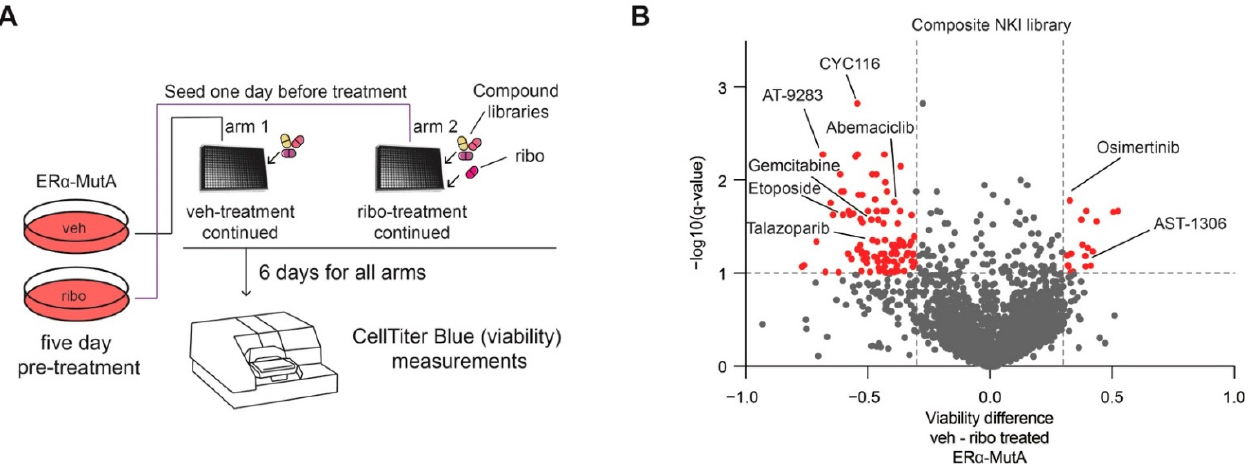
Figure 3. High-throughput drug screen identifies EGFR as a vulnerability of CDK4/6 inhibitor treated cells. ( A ) Schematic representation of the drug screen: ER α -MutA cells were seeded. On the following day, the drugs from the library were added at the concentration of 1 μ M. After six-day treatment. CellTiter Blue assay was performed and viability measured using fluorescence reader. ( B ) Volcano plot depicting the viability differences between two arms of the screen—vehicle or Ribociclib pre-treated ER α -MutA cells. Significant hits are depicted in red, and are based on two-tailed unpaired t -test with Welch corrections (with multiple correction Benjamin, Krieger, and Yekutieli test). Compounds without a differential effect are depicted in grey.